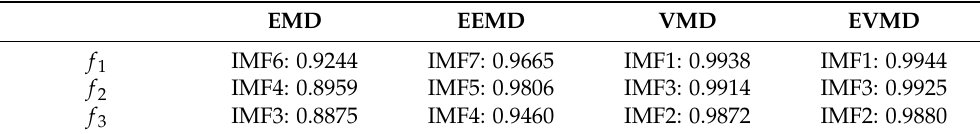
Table 2. Correlation coefficients between corresponding IMF with simulated